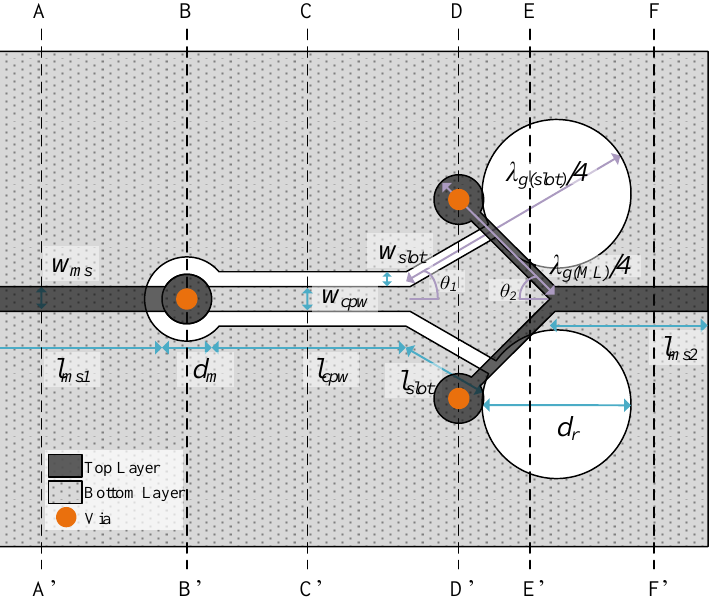
Table 1. Effective dielectric constants along the transition.